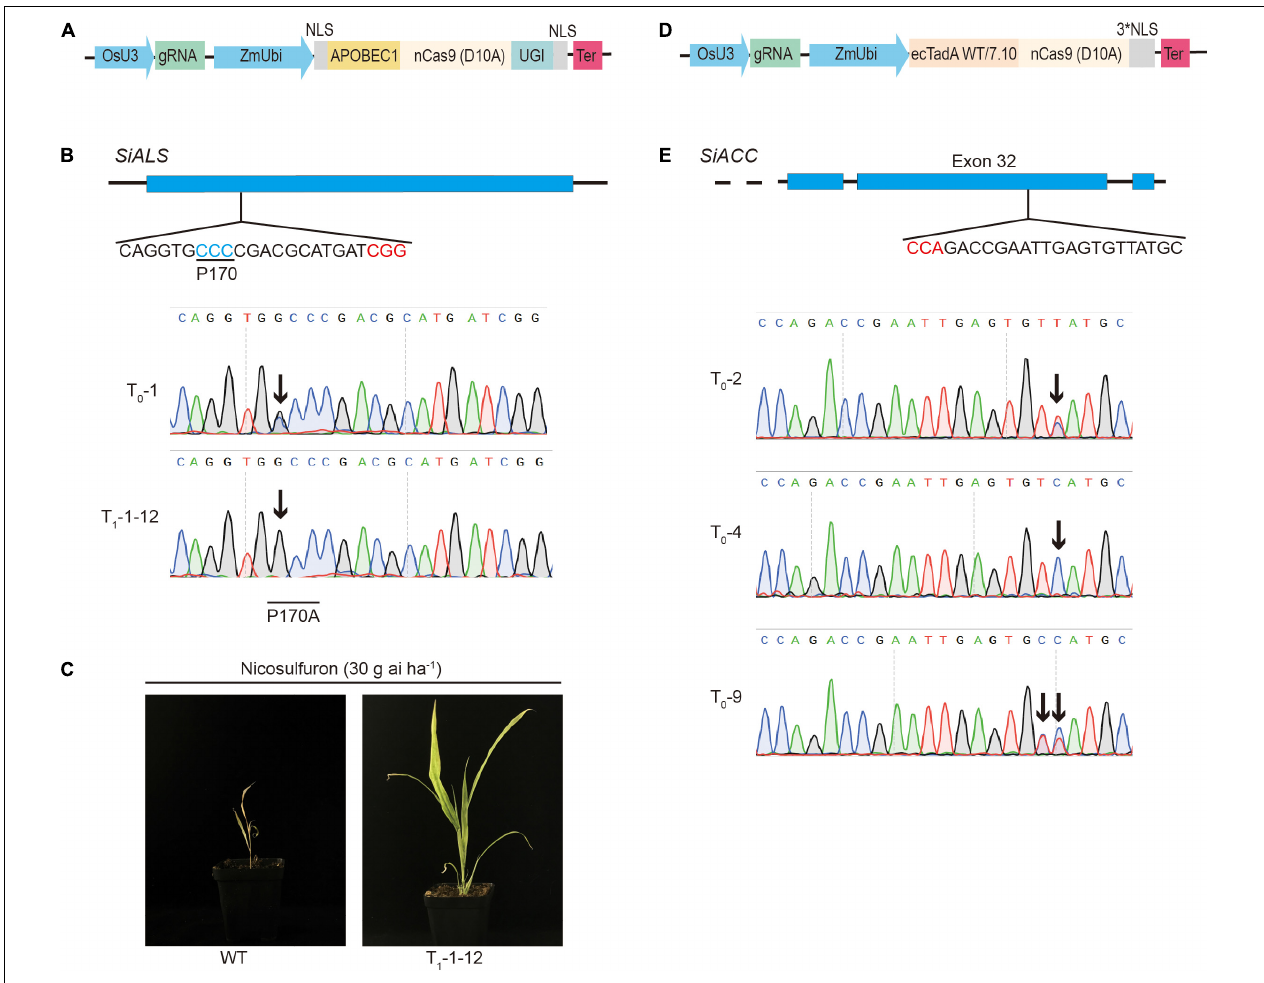
FIGURE 3 | Targeted nucleotide substitutions using cytosine and adenine base editors. (A) Schematic review of the cytosine base editor used in this study. (B) Targeted mutagenesis in the SiALS gene induced by CBE. The PAM sequence and P170 amino acid that conferred herbicide resistance were highlighted in red and blue, respectively. Sanger sequencing was used to analyze the T 0 transgenic plants. The mutated bases were indicated by black arrows. (C) Phenotypes of the homozygous P170A plants treated by nicosulfuron herbicide. (D) Schematic review of the adenine base editor used in this study. (E) Targeted mutagenesis in SiACC gene induced by